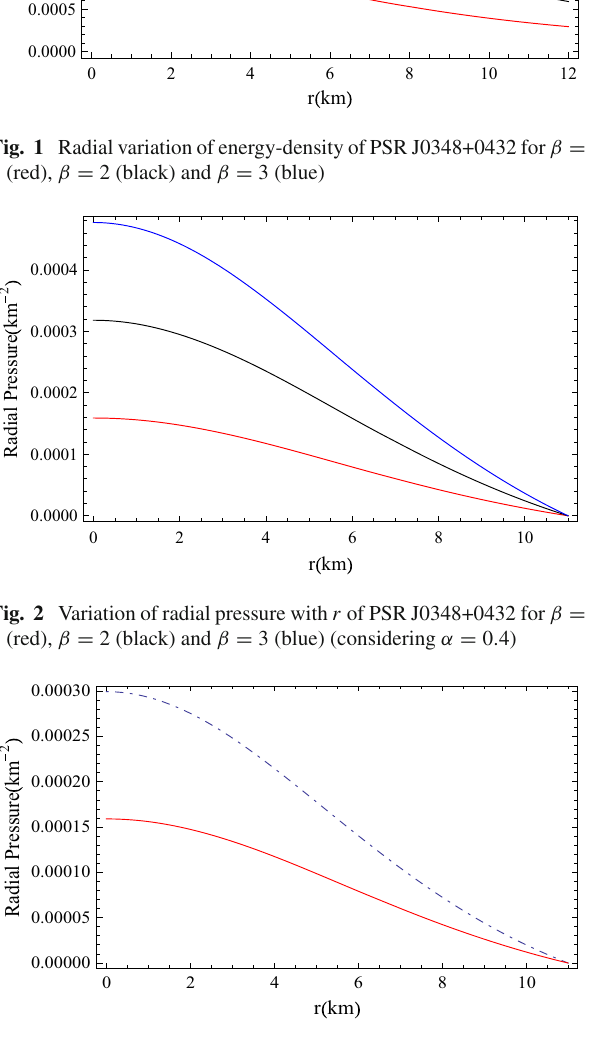
Fig. 3 Variation of radial pressure with r of PSR J0348+0432 for α = 0 (dot dashed) and α (cid:5)= 0